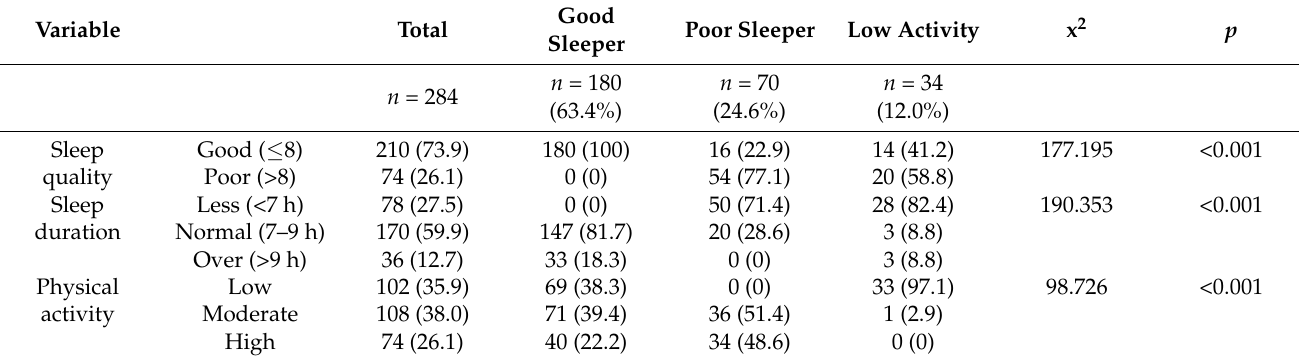
Table 2. Comparison of sleep quality and physical activity characteristics between three groups of pregnant women ( n